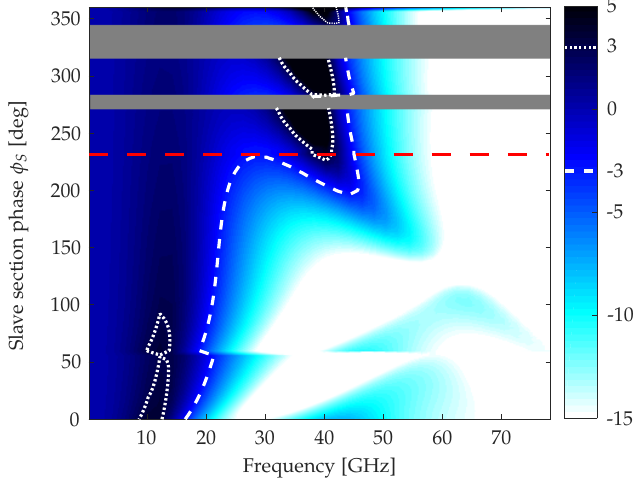
Figure 8. Modulation response map, in dB, for the device indicated by the red square marker in Figure4b, with, in the ordinate, the tuning phase shift φ S introduced in the slave optical cavity. The output power is approximately 25mW; I S = 60mA, I M = 8mA. Contour lines indicate (dashed line) and 3dB (dotted line) levels of the modulation response. The red dashed horizontal line indicates the operation condition chosen for the large signal